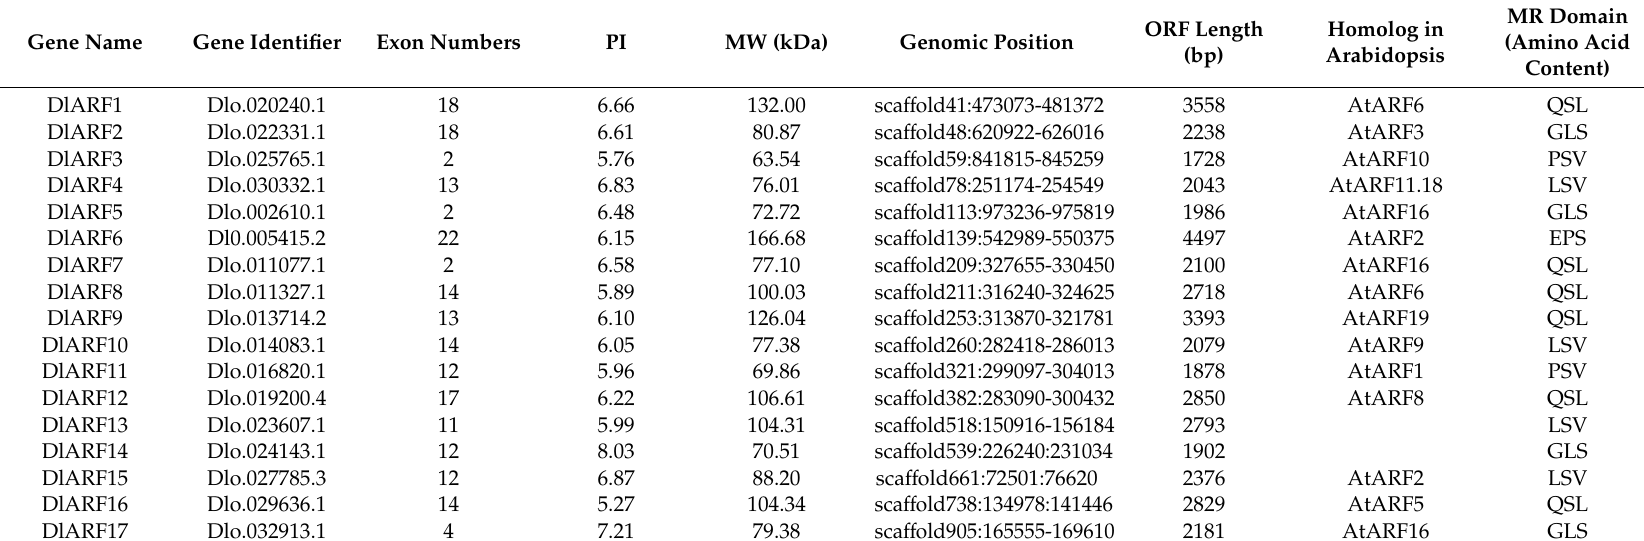
Table 1. Physical and chemical properties of ARFs in